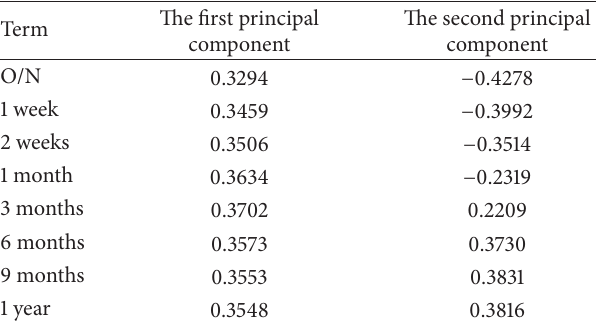
Table 2: The coefficient of the first two principal components of different terms of